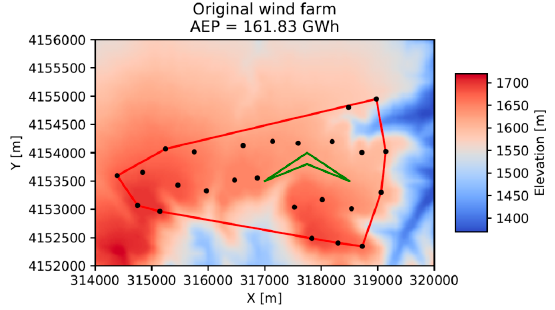
Figure 6. Original design of the anonymous wind farm in complex terrain. Appl. Sci. 2018 , 8 , x FOR PEER REVIEW